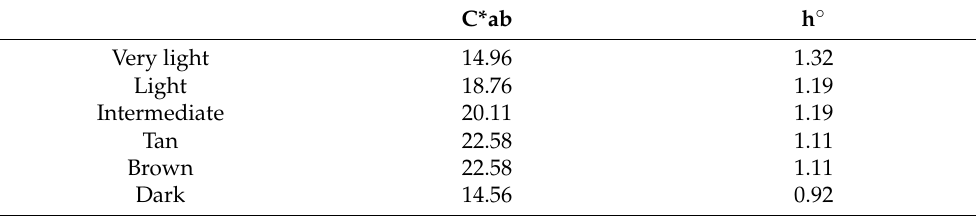
Table 4. Values for C*ab and h ◦ for the six groups of skin color as calculated from data of